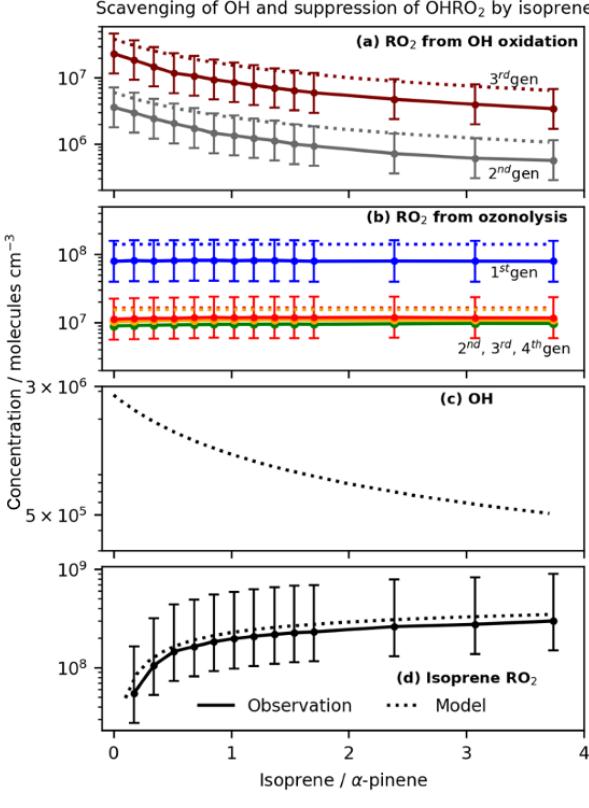
Figure 4. Observed and modelled variation for Simulation B of OHRO2 (a) , O3RO2 (b) , OH (c) and the peroxy radical formed from isoprene oxidation (d) with increasing isoprene (observed data from Berndt et al., 2018a). The model is able to reproduce the de- crease in OHRO2 as well as their concentrations. The fractional de- cline in OHRO2 mirrors that observed in the OH concentration, sug- gesting the major driver is OH scavenging. The error shown is the experimental error from Berndt et al.